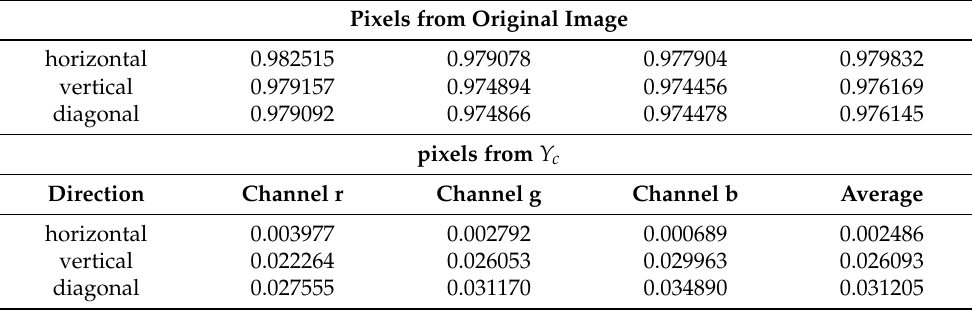
Table 6. Correlation values of adjacent pixels in image car.